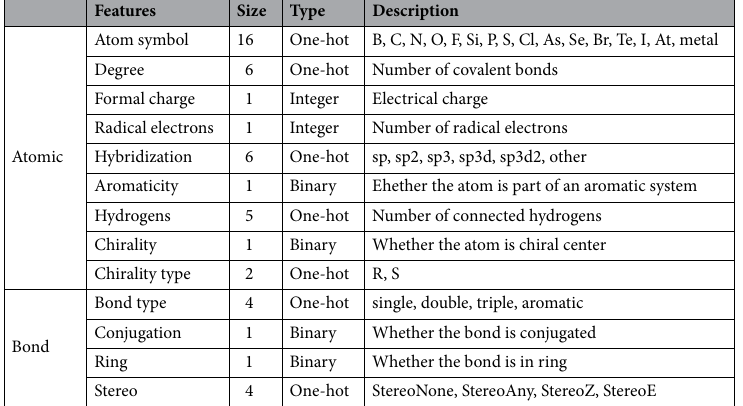
Table 2. List of input features.